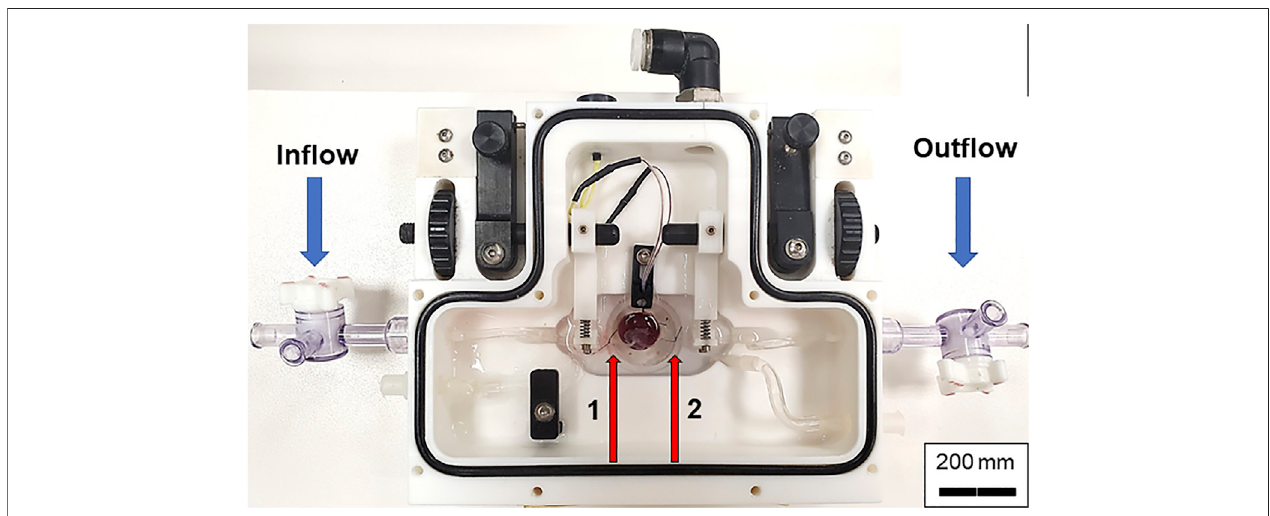
FIGURE 3 | Chamber set up for isolated placental perfusion. The placental unit with separated umbilical artery and vein is placed into the Living Systems chamber withPSS.Theumbilicalarteryiscanulatedontothein fl owglasspipettewhiletheumbilicalveiniscanulatedontotheout fl owpipetteandtiedwithbraidedsilksuture.Red arrows indicate the in fl ow (left, 1) and out fl ow (right, 2) pipettes.